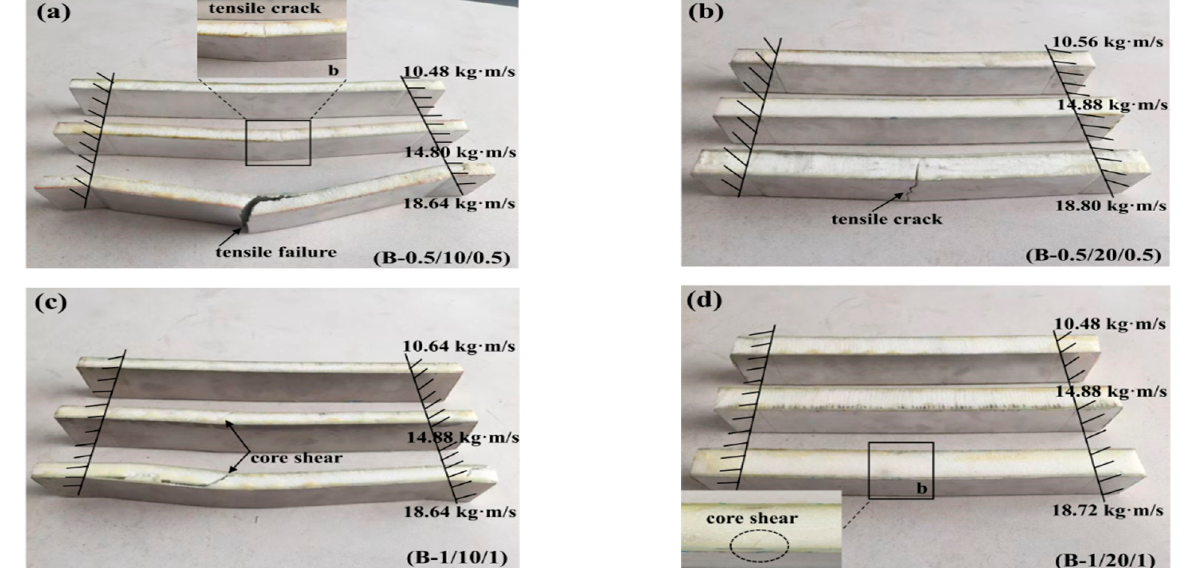
Figure 8. The failure modes of the sandwich beams: ( a ) B-0.5/10/0.5; ( b ) B-0.5/20/0.5; ( c ) B-1.0/10/1.0; ( d ) B-1.0/20/1.0.